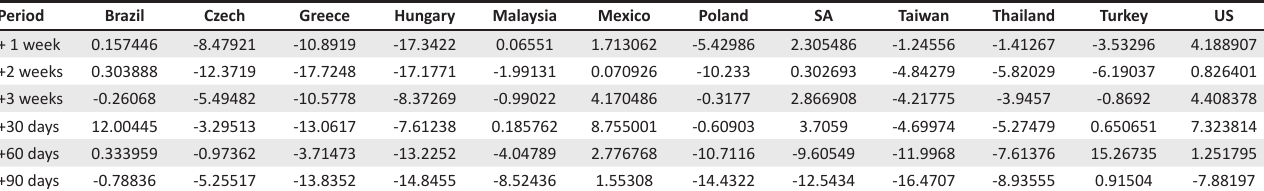
TABLE 4: Stock market returns after specified periods. Period